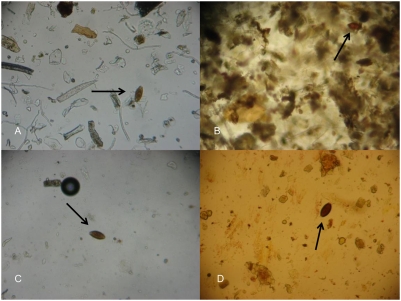
Appearance of microscope slides loaded with egg samples prepared by the ether technique (A), the Parasep SF (B), the McMaster (C) and the FLOTAC (D).Arrows indicate Trichuris eggs.